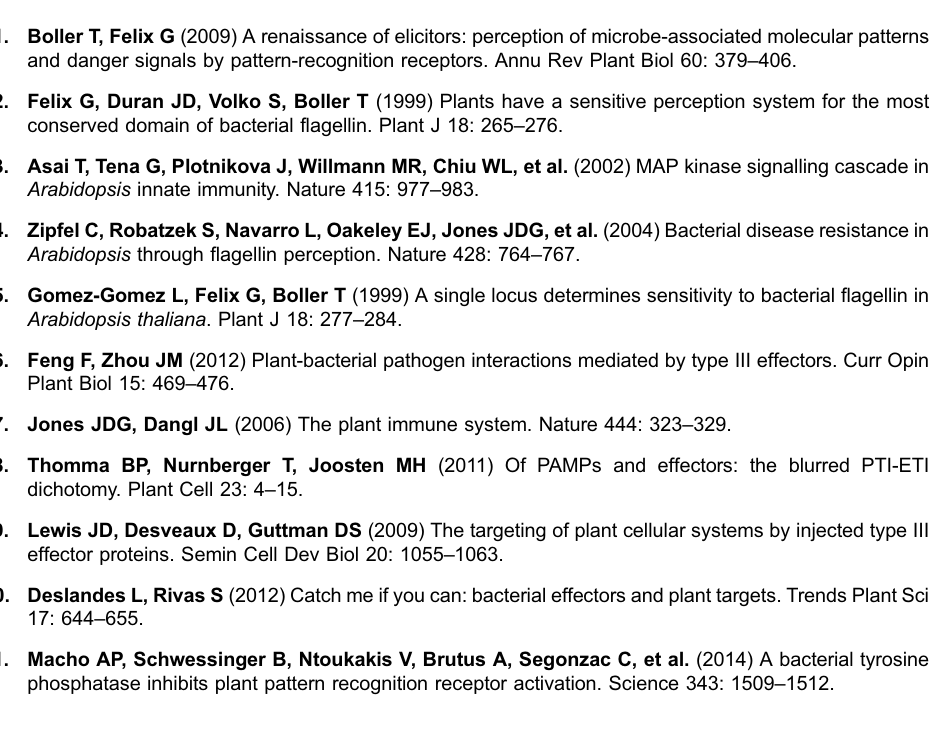
S1 Table. GenBank accession numbers and P. syringae strain for each member of the HopZ